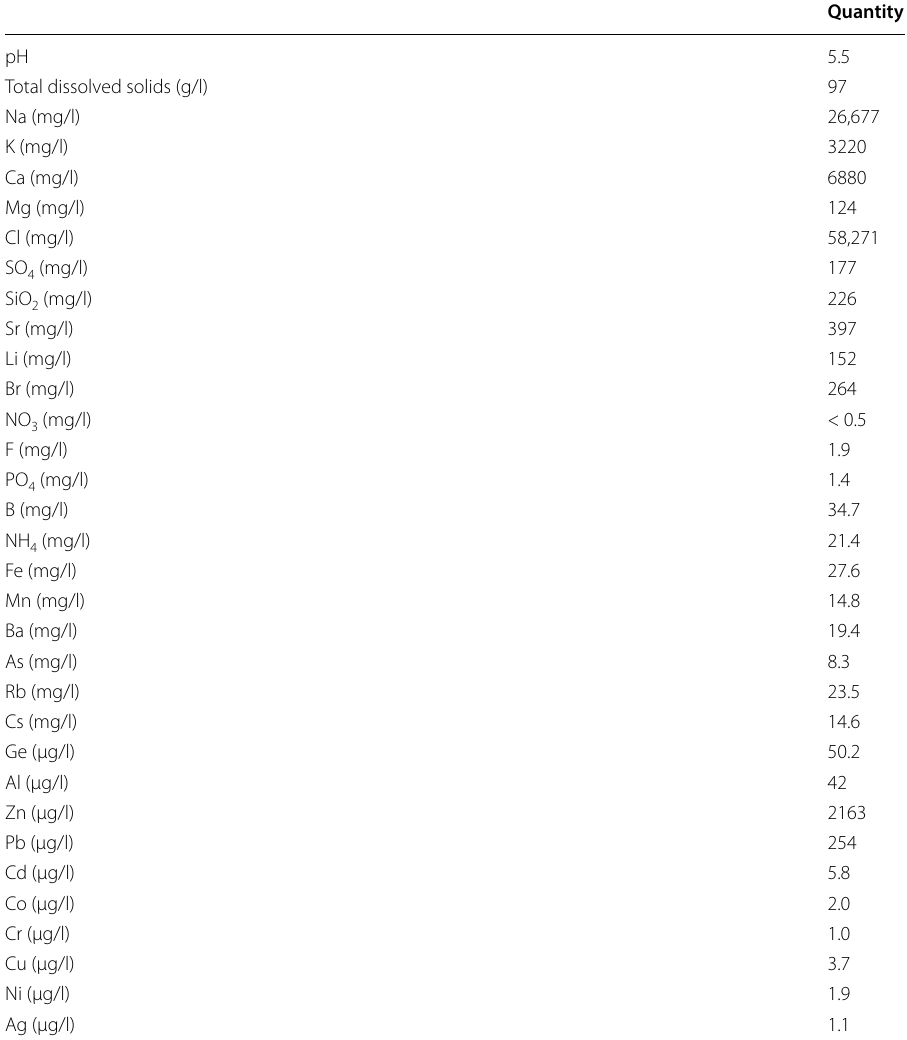
Table 3 Composition and properties of the hydrothermal fluid sampled from production well GPK‑2 at Soultz‑sous‑Forêts (France) in 2011. Data from Scheiber et al.